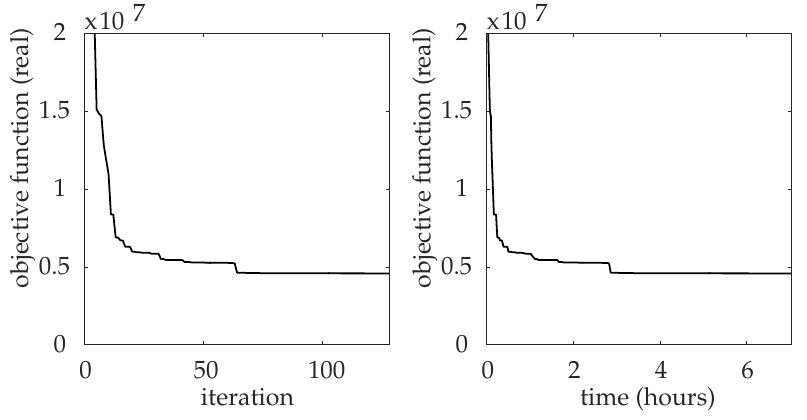
Figure 1. Performance of the GABC for 43 nodes.